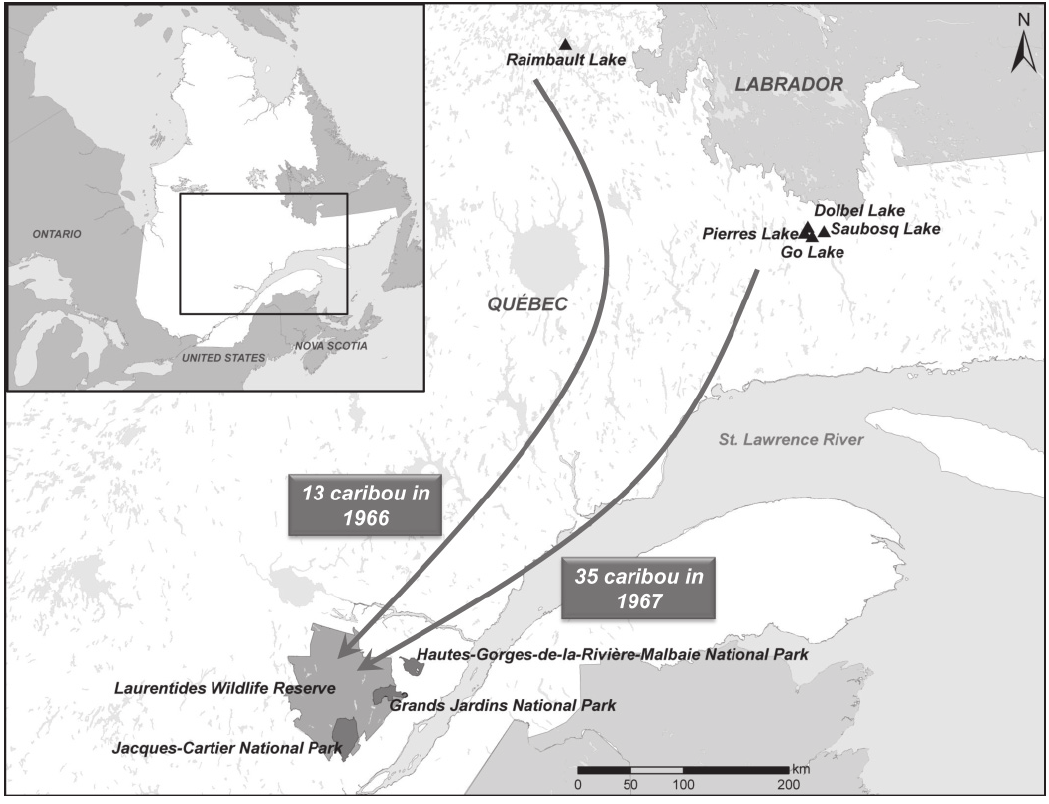
Fig. 1. Location of the sites where caribou were captured for reintroduction in the Charlevoix area in 1966 and 1967. The current location of the Laurentides Wildlife Reserve, the Jacques-Cartier National Park, the Grands-Jardins National Park and the Hautes-Gorges-de-la-Rivière-Malbaie National Park is also indicated (adapted from Sebbane et al. ,